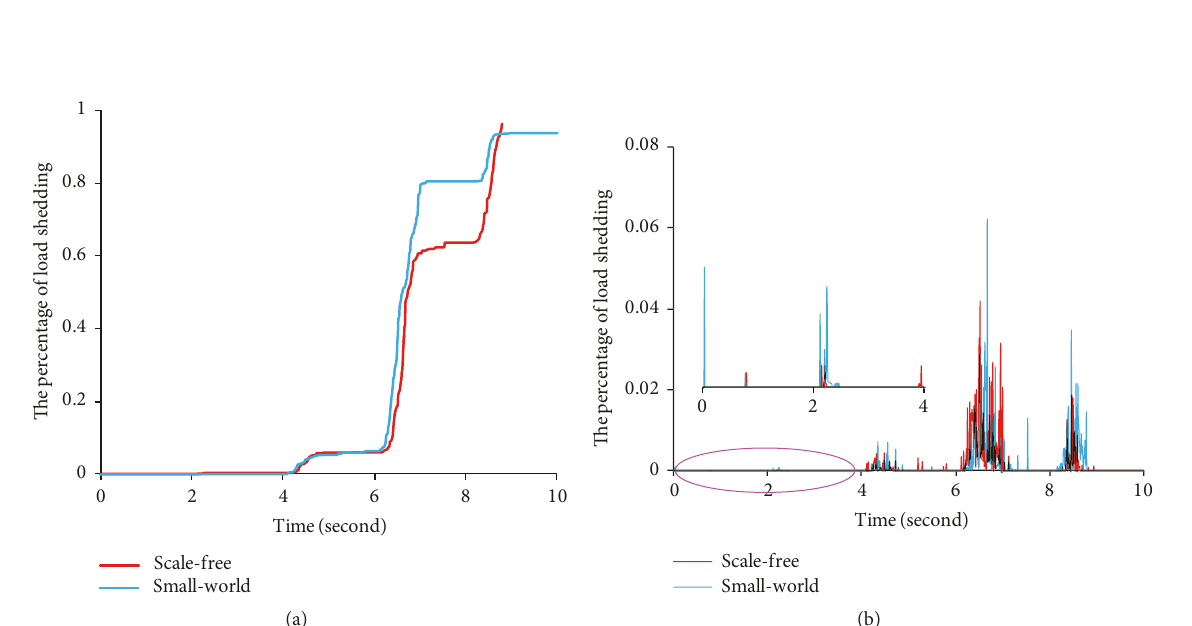
Figure 7: Load shedding of IEEE118-bussystem over timebased on SIR model. (a)Total load shedding over time; (b) real-timeload shedding.